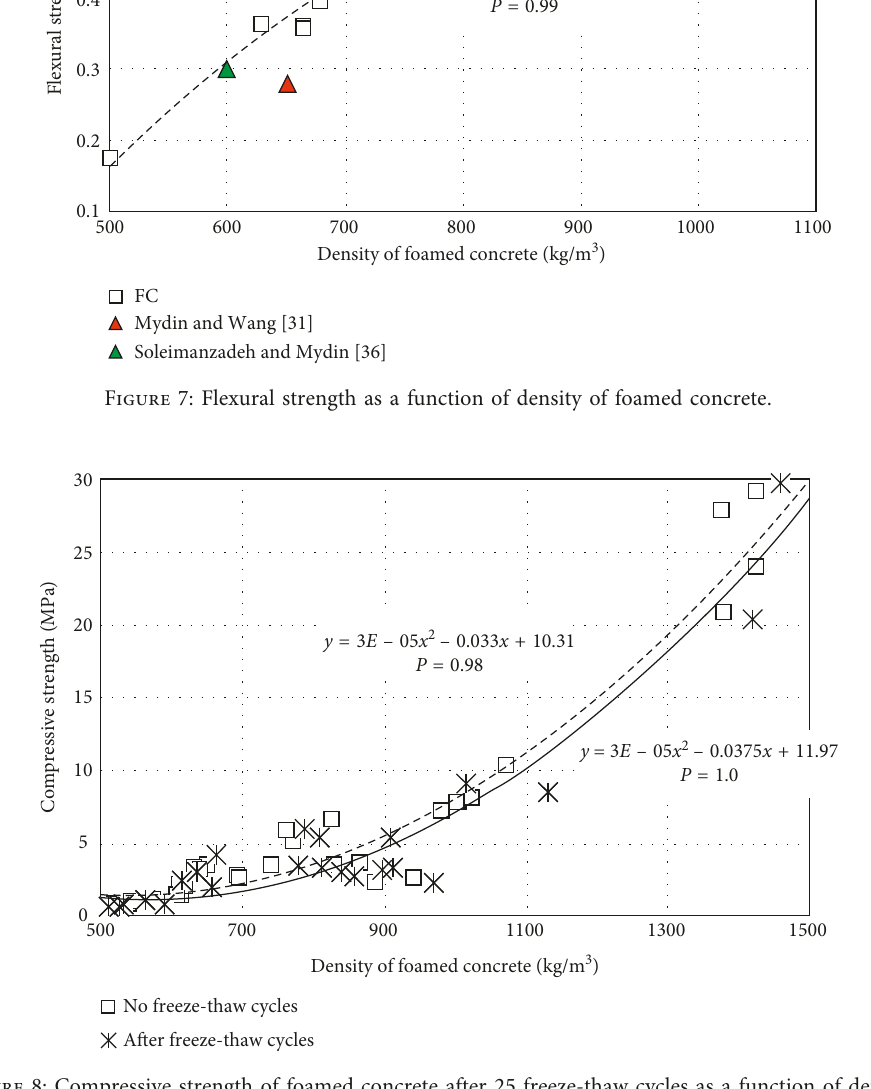
Figure 8: Compressive strength of foamed concrete after 25 freeze-thaw cycles as a function of